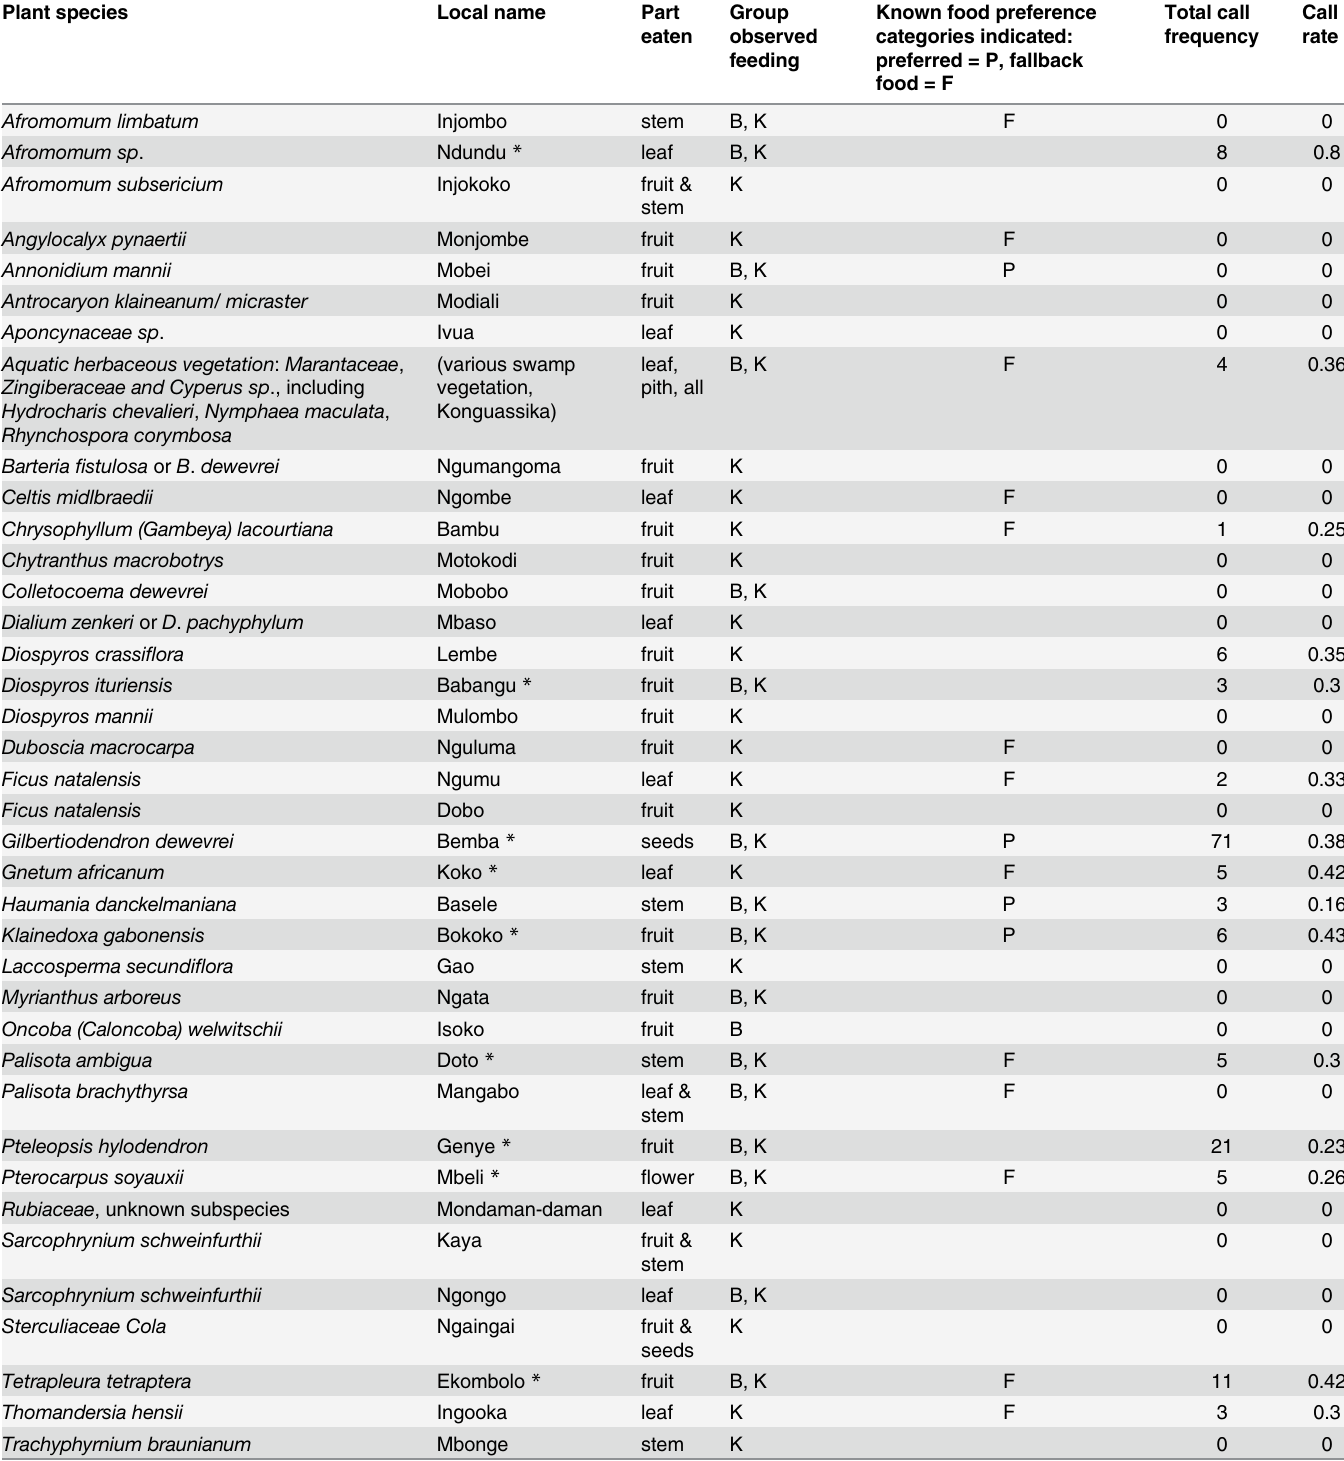
Table 2. Foods of the gorilla diet between July and September 2012. Total call frequency and call rates per feeding session are indicated. All fruit was ripe. Plant